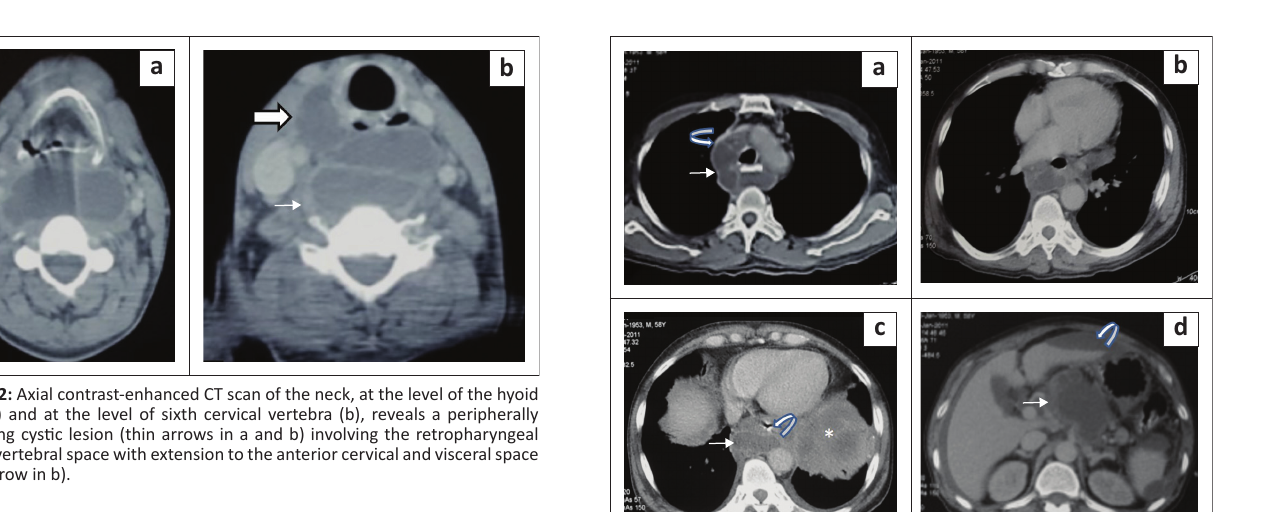
FIGURE 1: Radiograph of the neck, anteroposterior (a) and lateral (b), demonstrates anterior displacement of the airway and oesophagus (thick arrow) and widening of the prevertebral soft tissue (thin arrow). The frontal chest radiograph (c) indicates displacement of the right paraspinal stripe (thin arrows) and a retrocardiac opacity (thick arrow) indenting (curved arrow) the gastric fundus (asterisk).